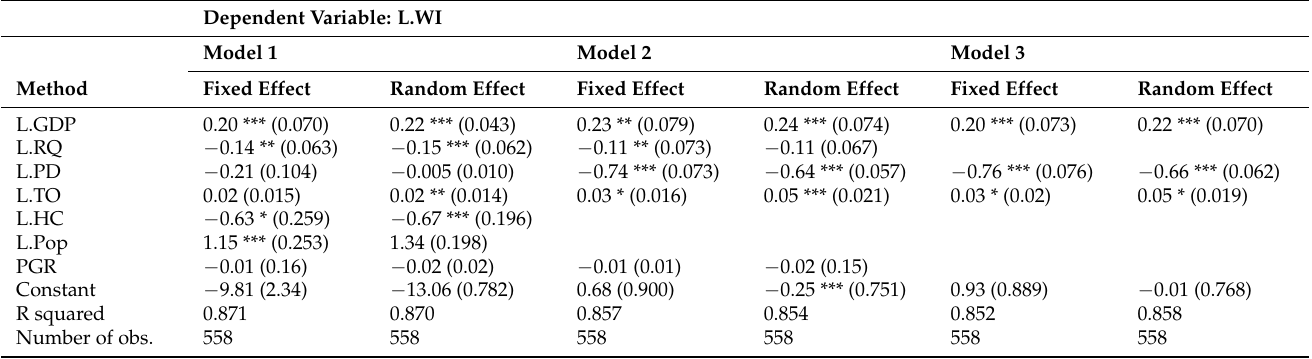
Table 3. Estimation results of the drivers of water infrastructure